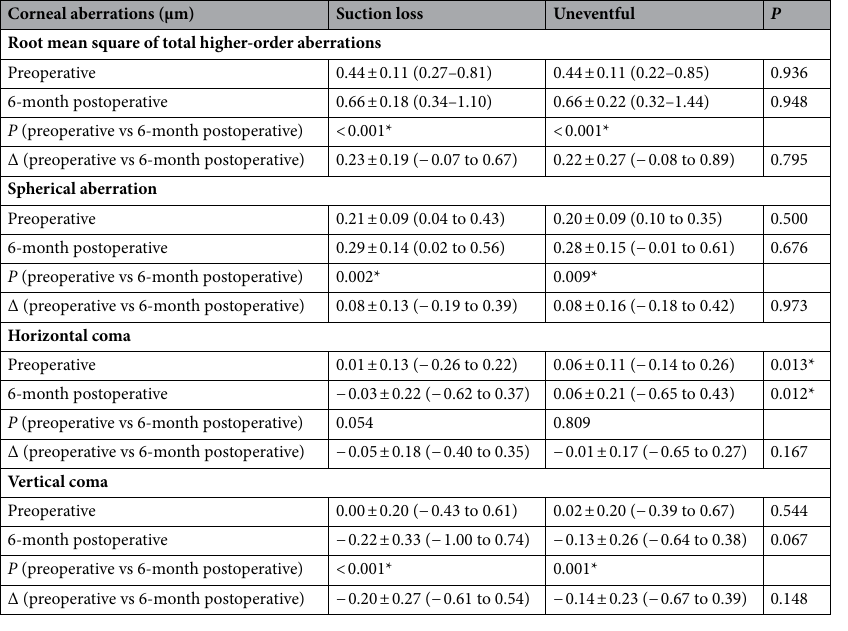
Table 3. Comparison of corneal aberrations (μm) of eyes that underwent immediate SMILE reapplication after suction loss and contralateral uneventful SMILE groups. Results are expressed as mean ± standard deviation (range). Δ = change. *Significant statistical difference between preoperative and postoperative values.